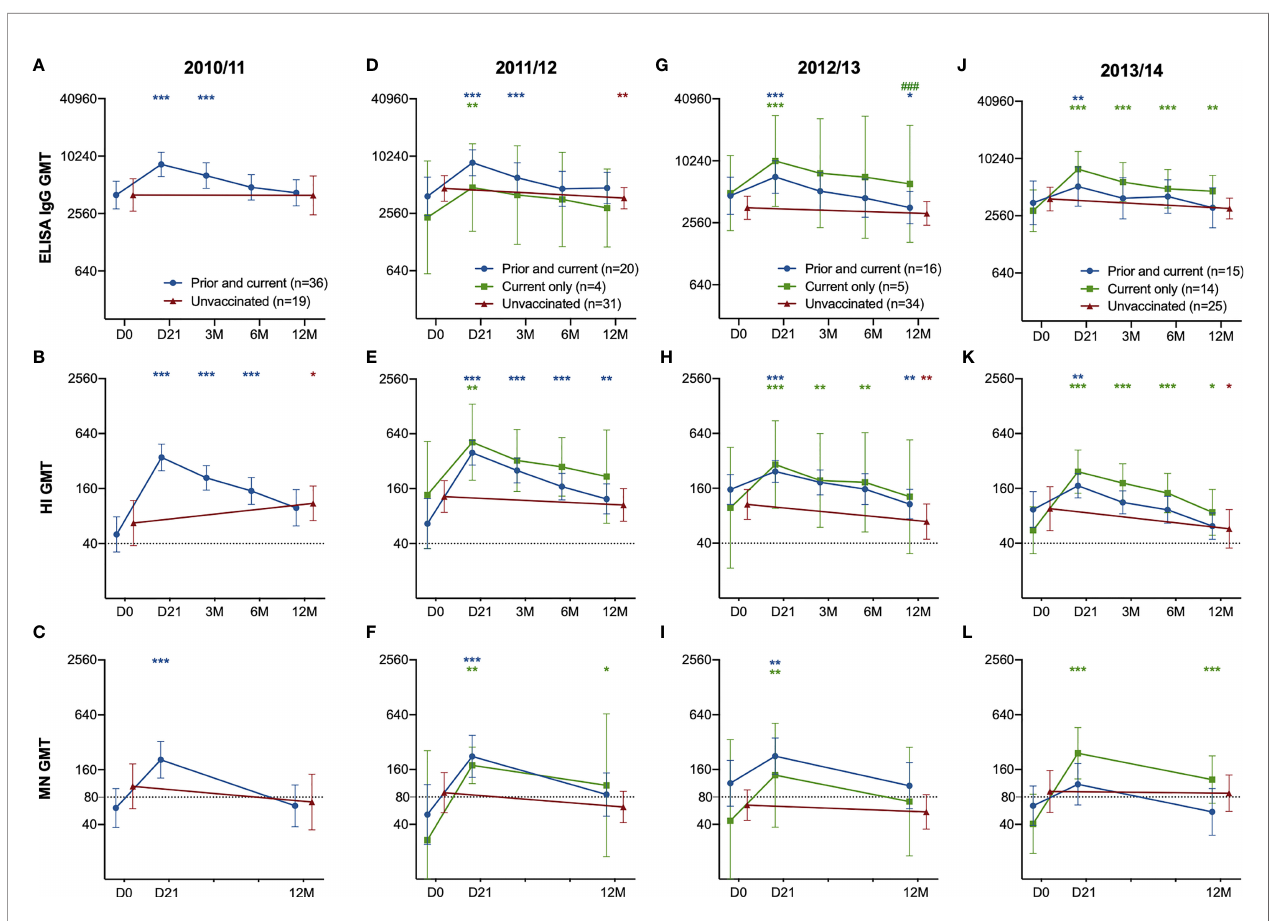
FIGURE 2 | The H1N1pdm09-speci fi c ELISA IgG, HI and MN antibody response in HCW with the prior and current vaccination, current vaccination only and unvaccinated HCW. The ELISA IgG (A) , HI (B) and MN-titres (C) in HCW who received the prior & current vaccination in 2010/11 compared to unvaccinated HCW in 2010/11. The ELISA IgG (D, G, J) , HI (B, E, H, K) and MN titres (C, F, I, L) in HCW who received the prior & current vaccination in 2011/12 – 2013/14 compared to HCW who received only the current vaccination, and unvaccinated HCW. The geometric mean titres with 95% con fi dence interval are presented. The dotted line at 40 and 80 represents the protective titre, in HI and MN respectively. The data was log-transformed and analysed with the two-way ANOVA with Dunnetts test for multiple comparisons, for detecting differences within a group. Statistical differences between the groups were tested with linear mixed-effect models, with Dunnett´s test for multiple comparisons. The stars indicate signi fi cant increases within a group, with pre-vaccination titres (D0) as the reference timepoint. ***P < 0.001, **P < 0.01, *P < 0.05. ### Indicates statistical differences (P<0.05) between